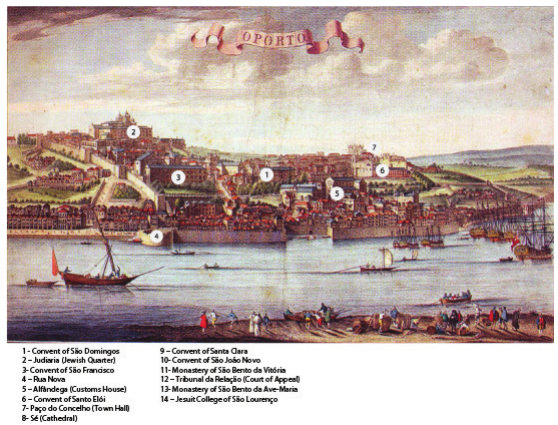
Figure 10: The anima urbis in an engraving of the 18th